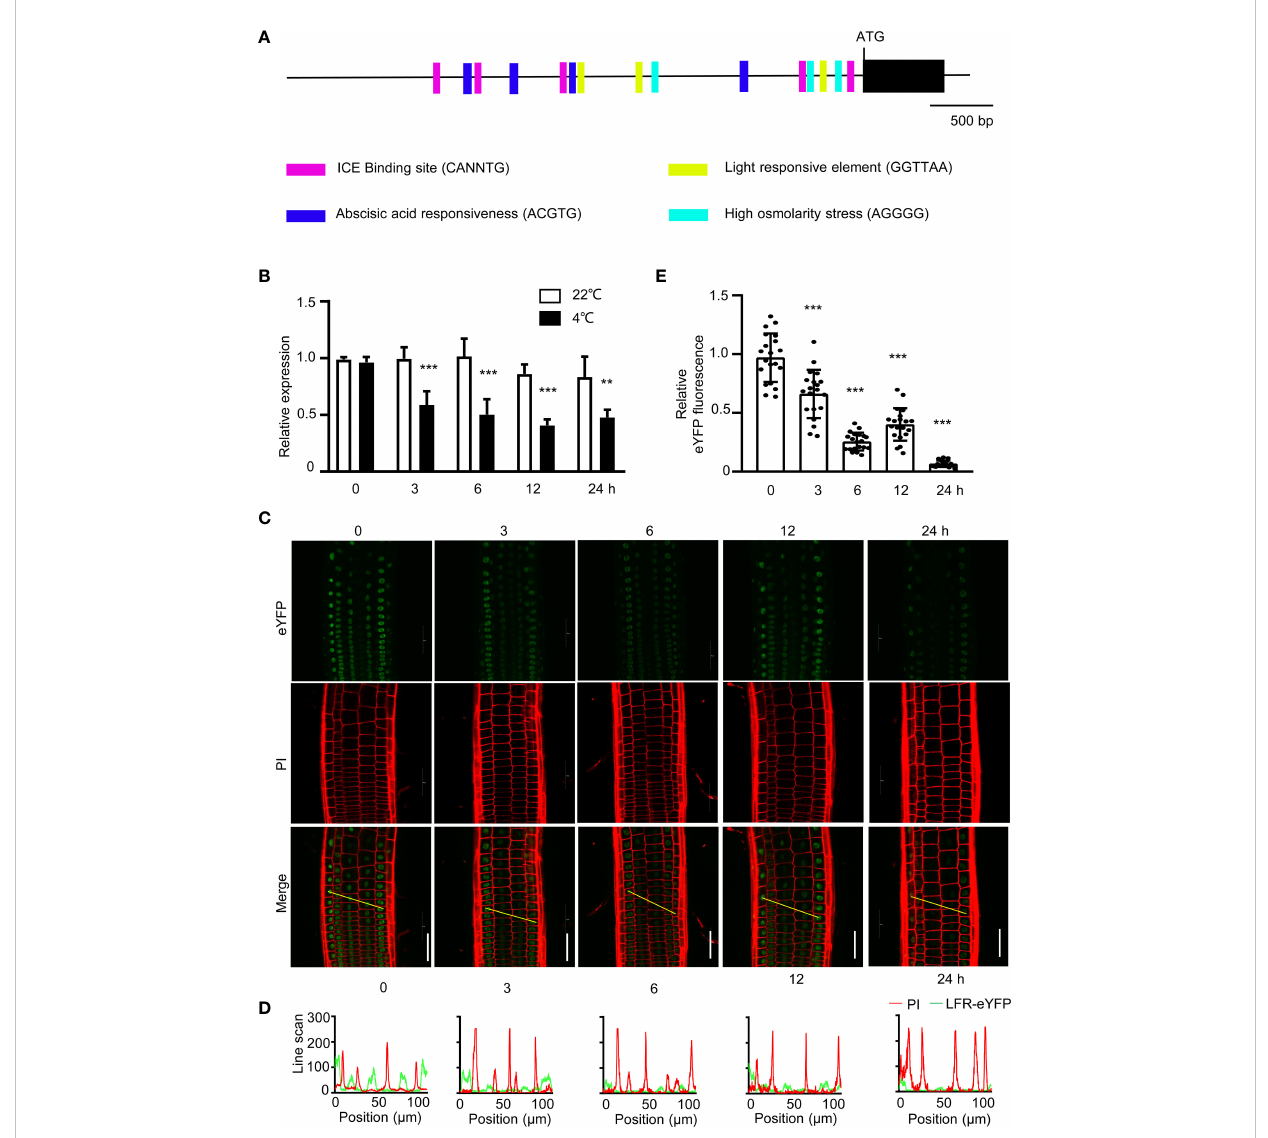
FIGURE 6 The expression of LFR are regulated by cold stress. (A) Cis -element analysis of the LFR promoter. Different cis -elements are indicated by different symbols. CANNTG is the low temperature-responsive element found in the ICE1 binding site. (B) RT- qPCR data showing the transcript level of LFR with (4°C) or without (22°C) cold treatment. RNA was isolated from 8-day-old Col-0 seedlings with or without cold treatment for 0, 3, 6, 12, or 24 h. eLF4A1 served as an internal control. Error bars indicate the SD of three biological replicates. Statistically signi fi cant differences are indicated by asterisks. **P<0.01 and ***P<0.001, Student ’ s t -test. (C) Representative YFP signals observed in the roots of 8-day-old seedlings of pLFR : LFR - eYFP / lfr-2 complemented transgenic lines as detected by confocal microscopy with (4°C, for 3, 6, 12, or 24 h) or without (0 h) cold treatment are shown. PI staining indicates the cell membrane. Scale bar= 50 m m. (D) Line scan analyses of the YFP (green line) and PI (red line) signals corresponding to the yellow lines indicated in (C) (Merge). YFP signals were signi fi cantly reduced after cold treatment. (E) Quanti fi cation of the YFP fl uorescence in (C) . Representative data from one of three biological replicates with similar results are shown. Data are shown as the mean ± SD (n=20). ***P < 0.001; Student ’ s t